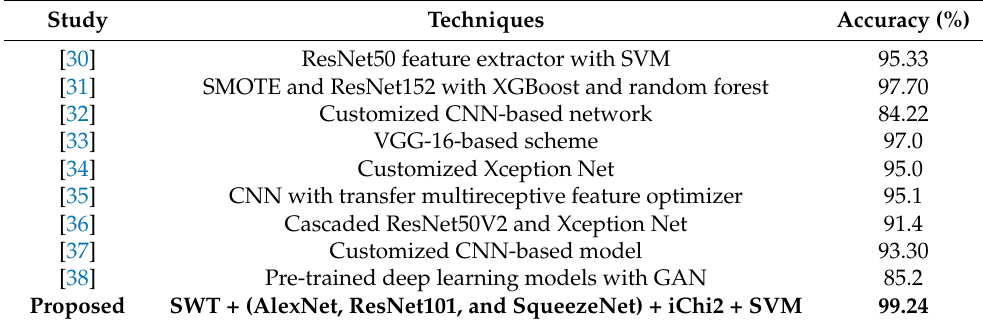
Table 9. Comparative analysis of the proposed study with prior